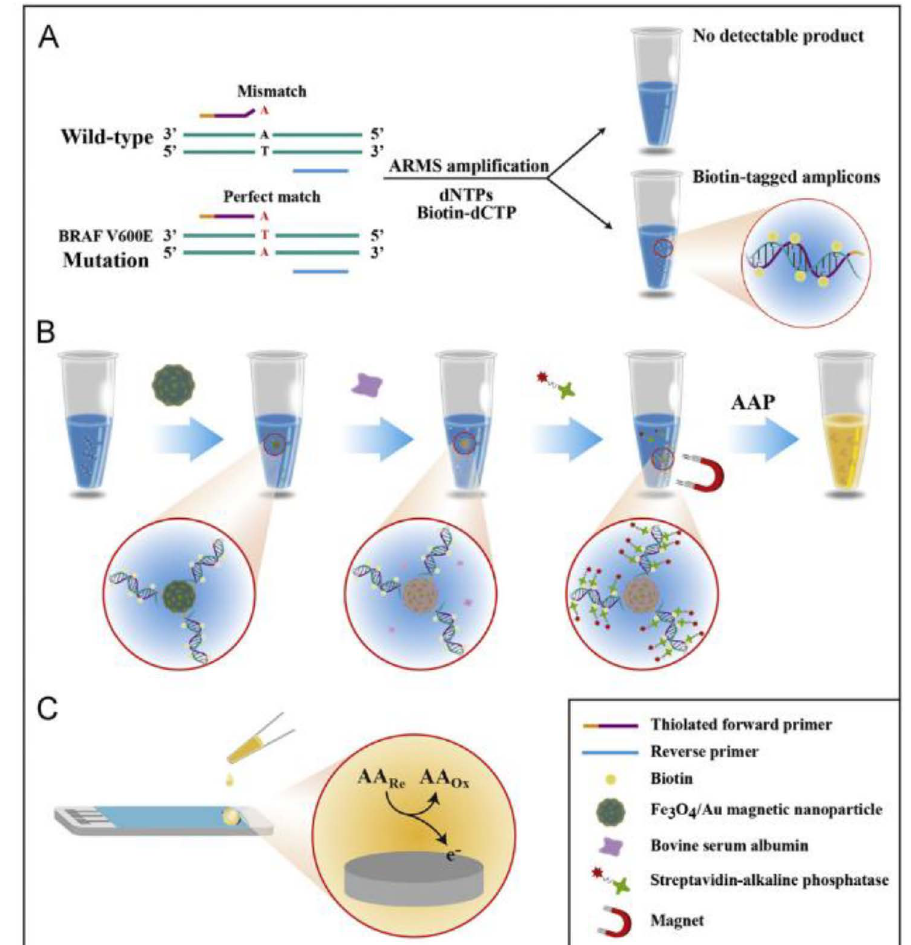
Figure 9. Scheme of the electrochemical assay of BRAF V600E mutation: ( A ) amplification of ARMS using thiol groups and biotinylated labels; ( B ) process for preparing multienzyme functionalized Fe 3 O 4 /AuNPs; ( C ) ascorbic acid oxidation at SPCE. Reprinted from Ref. [88] with